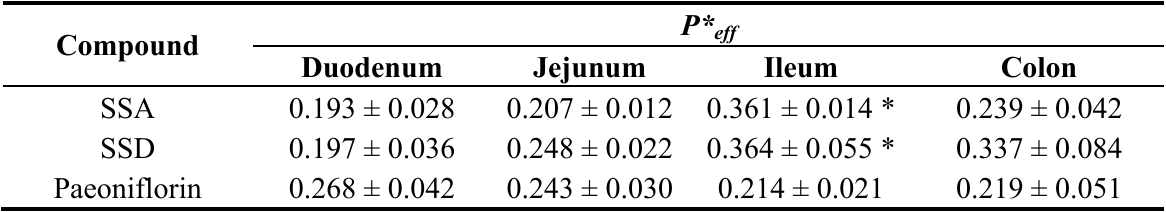
Table 1. Permeability of SSA, SSD and paeoniflorin in different intestinal segments ( x ± s, n = 4). Compound